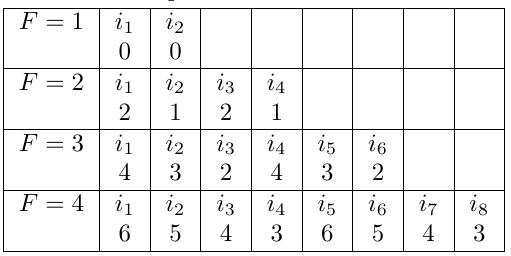
Table 4: Number of permutations of zero harmonic ( N 0 )